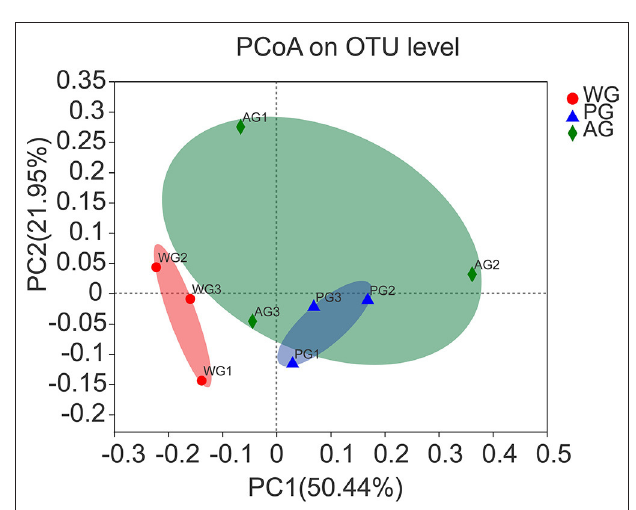
FIGURE 2 | Principal coordinate analysis (PCoA) of rumen bacterial community structures of steers in the three groups. PCoA plots based on weighted UniFrac distance. Steers were fed a wheat straw diet (WG), n = 4; Steers were fed a peanut vine diet (PG), n = 4; Steers were fed alfalfa hay diet (AG), n =